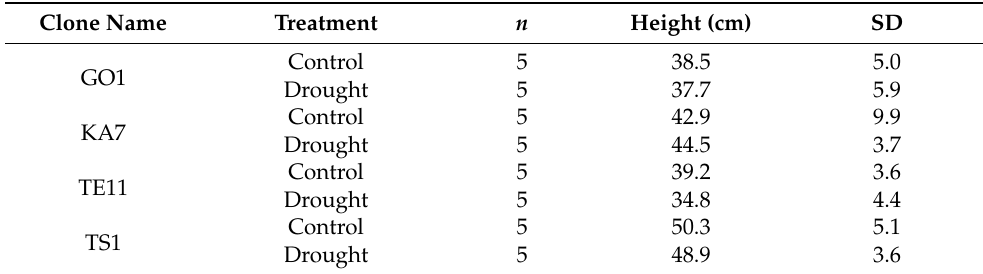
Table 1. Mean height of the four clones at the start of the